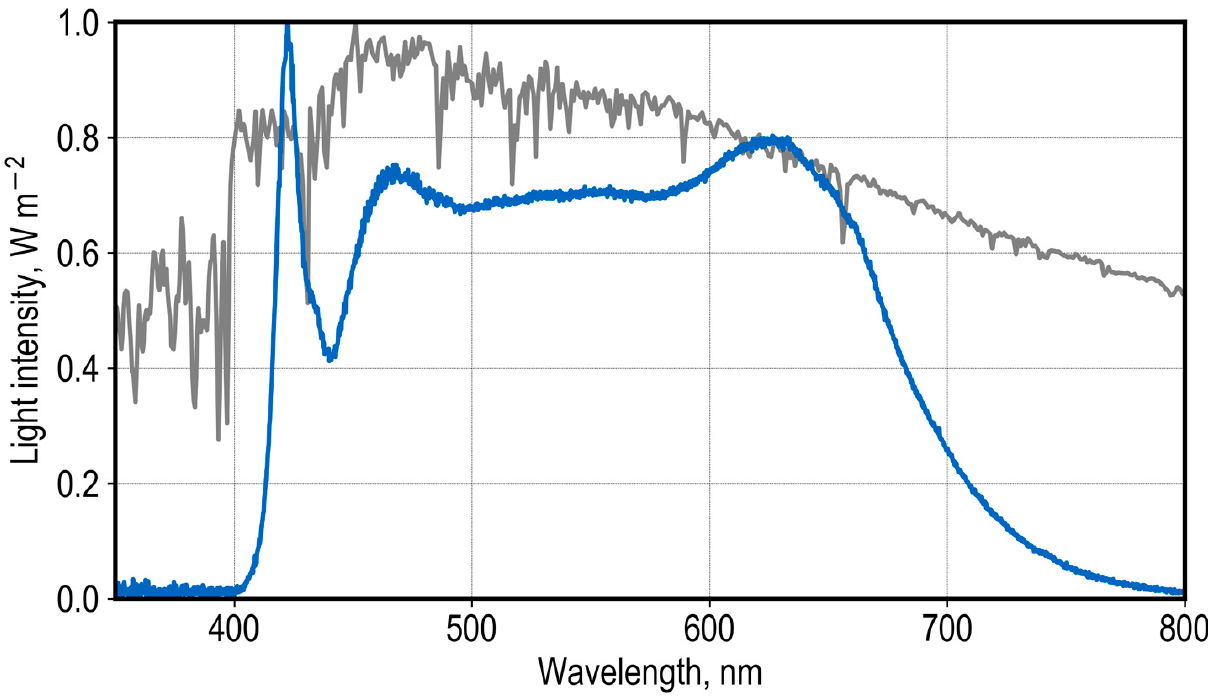
Figure 3. Normalized light intensities of the solar spectrum ASTM G173-03 (gray) derived from SMARTS v. 2.9.2 (ASTM, 2003) compared with the normalized light intensities of the spectrum of the LEDs used in the illumination modules (blue). Both spectra were normalized by dividing each value by the maximum value of the respective spectrum.